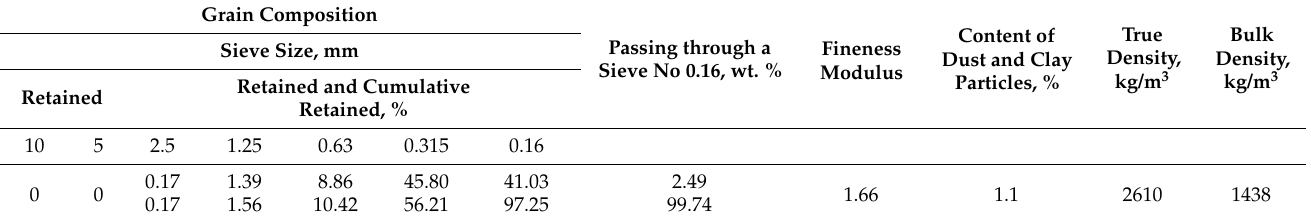
Table 3. Physical characteristics of dense fine aggregate.